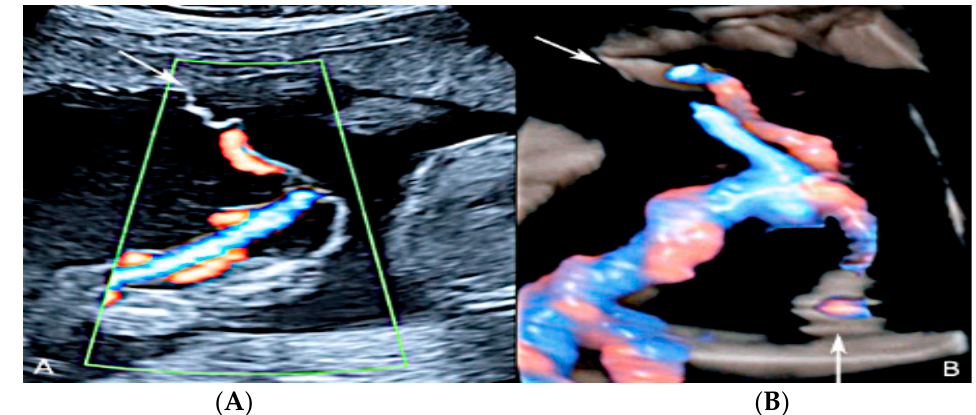
Figure 21. Twin pregnancy at 16 week’s gestation. Two-dimensional ultrasound ( A ) and four-dimensional STIC with color Doppler ultrasound ( B ) shows a particular velamentous insertion of the cord’s vessels that run through the intertwin membranes before joining the placenta (arrows).